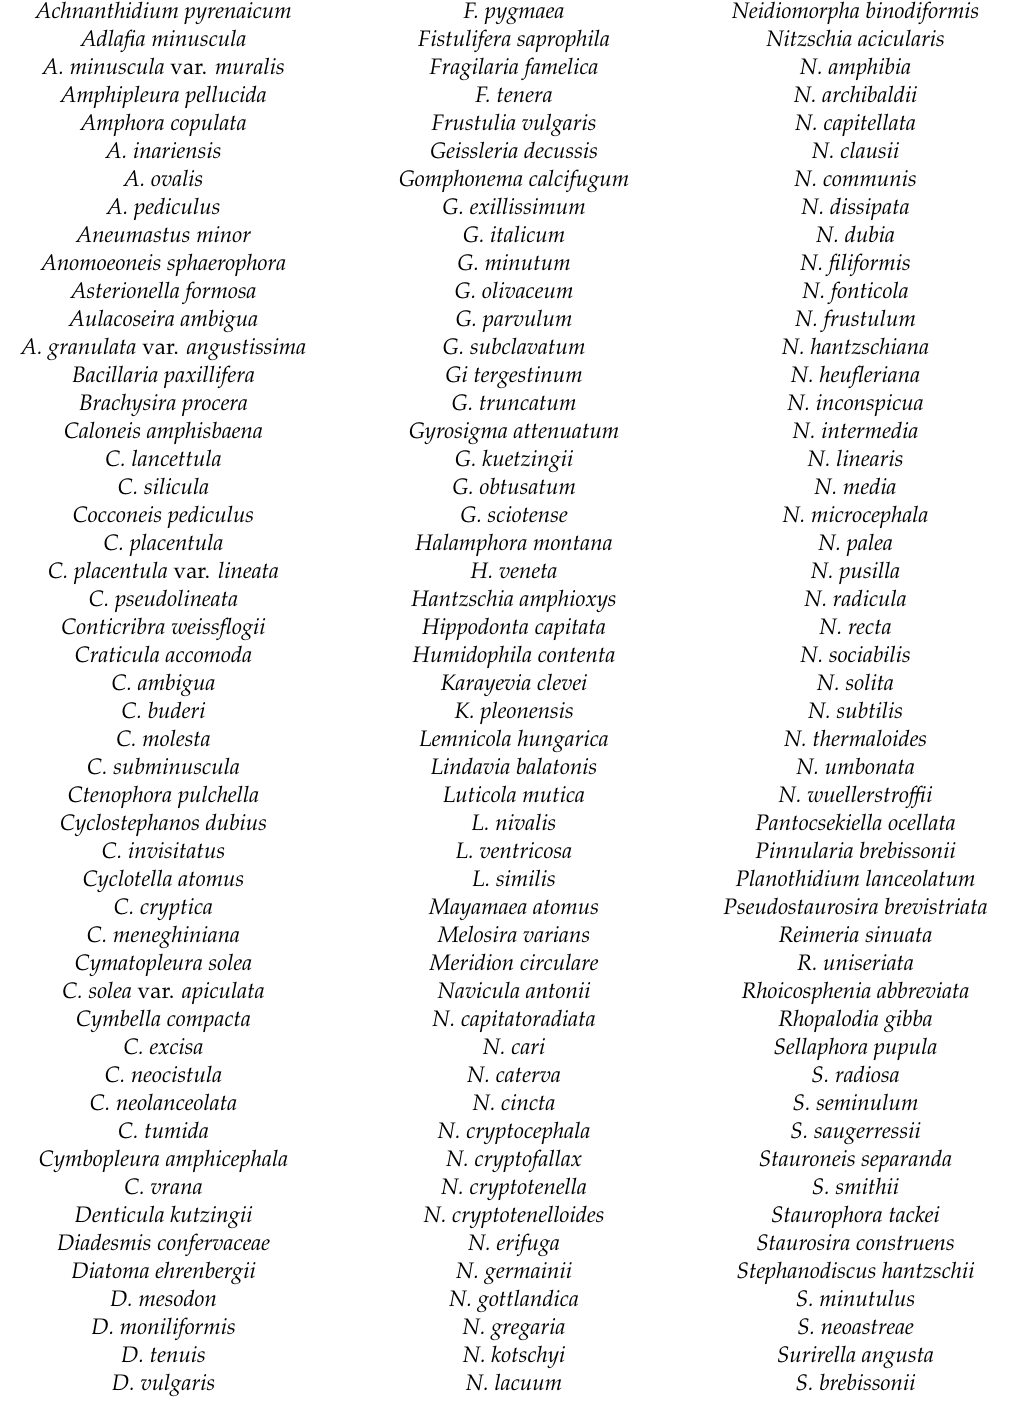
Table 4. Diatom taxa recorded during